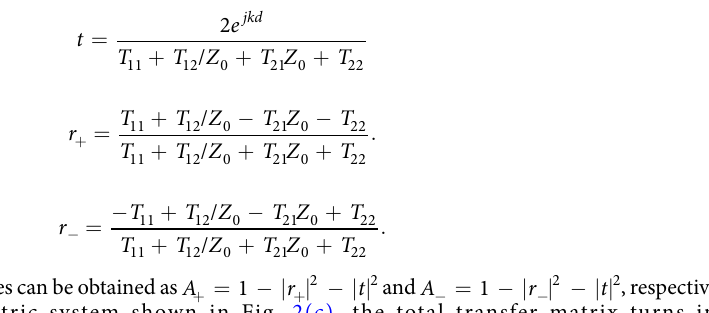
parallel-mounted MHRs is equivalent to a virtual ultrathin surface with impedance = Z Z /4 (sketched by para MHR the brown surface in the inset of Fig. 2(a)), where the relative impedances Z para and Z MHR normalized by air are plotted by lines and symbols, respectively. Note that Z para = (0.02–0.005 i ) Z 0 = (8.3–2.49 i ) kg/m 2 s at the resonant frequency of 356 Hz while Z para = (0.09–0.004 i ) Z 0 = (37.35–1.66 i ) kg/m 2 s at 963 Hz, which are far smaller than that of air ( Z 0 = 415 kg/m 2 s), as shown in the insets. Thus, the parallel-mounted MHRs can serve as a “soft” effec- tive boundary at the two resonant frequencies. In addition, the system functions as a point symmetric scatterer, and the absorptance is constrained at 0.5 due to the continuity of sound pressure at the impedance surface 10 , i.e., the absorptance are 0.25 and 0.48 at the corresponding resonant frequencies. To break the limitation, a single MHR is mounted before the parallel-mounted MHRs as shown in Fig. 2(b). The system functions as an asymmet- ric absorber: (1) when sound waves impinge from the left port (as sketched by I + in the inset), the sound energy are neither transmitted ( → + T 0 ) nor reflected ( → + R 0 ), and the system produce resultant near-perfect absorptance instead. (2) On contrary, the sound waves radiated from the right port ( I - ) has little transmittance ( → − T 0 ) but large reflectance ( → − R 1 ), and the absorption in this case is weak consequently. Here, the sub- scripts ( + / − ) stand for the propagation directions, i.e., “ + ” is for sound waves radiating from the left port (the red arrow) and “ − ” from the right port (the blue arrow). Furthermore, by connecting another MHR symmetrically behind the soft boundary as shown in Fig. 2(c), the original asymmetric absorptive system turns into a mirror symmetric one. Due to the shared soft boundary at the symmetric center, the system can efficiently absorb the sound energy radiated from both ports. Transfer matrix analyses are further employed to demonstrate the reconfigurable extraordinary absorptions of the systems quantitatively. For the asymmetric system depicted in Fig. 2(b), the sound pressures and velocities in the input port and the exit port can be related by the transfer matrixes